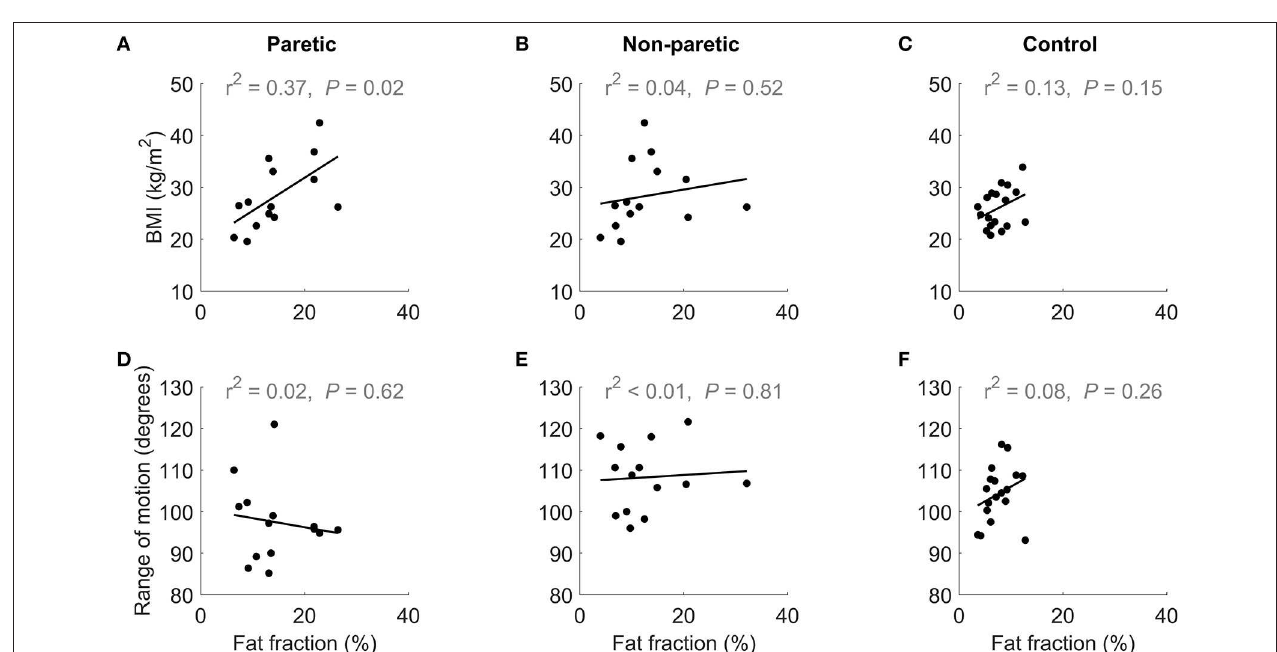
FIGURE 4 | The upper row shows the relationship between BMI and medial gastrocnemius fat fraction in the (A) paretic and (B) non-paretic muscles of stroke patients, and (C) control participants. The lower row shows the relationship between of dorsiflexion range of motion and medial gastrocnemius fat fraction in the (D) paretic and (E) non-paretic muscles stroke patients, and (F) control